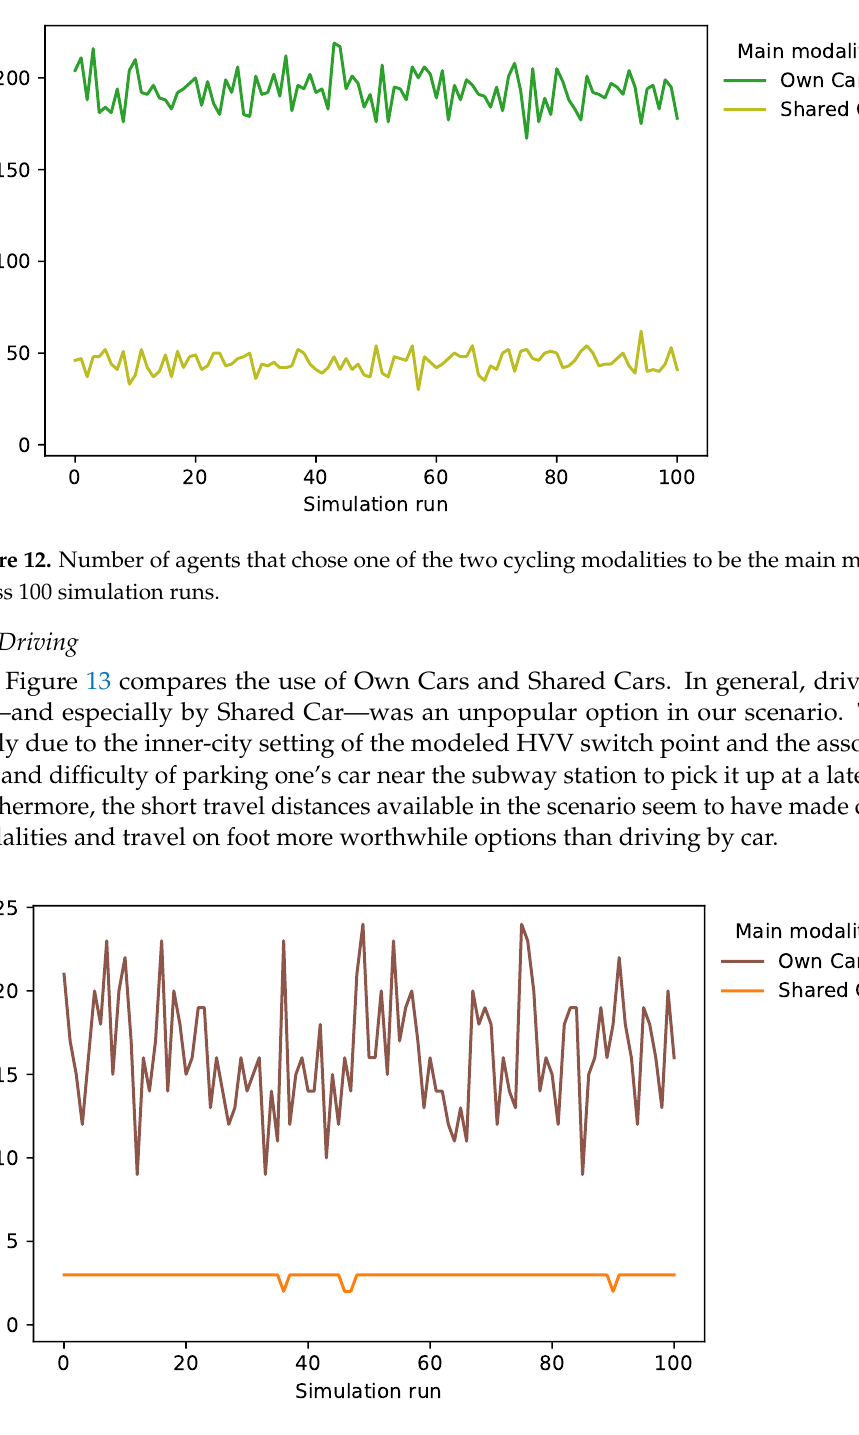
Figure 13. Number of agents that chose one of the two driving modalities to be the main modality across 100 simulation